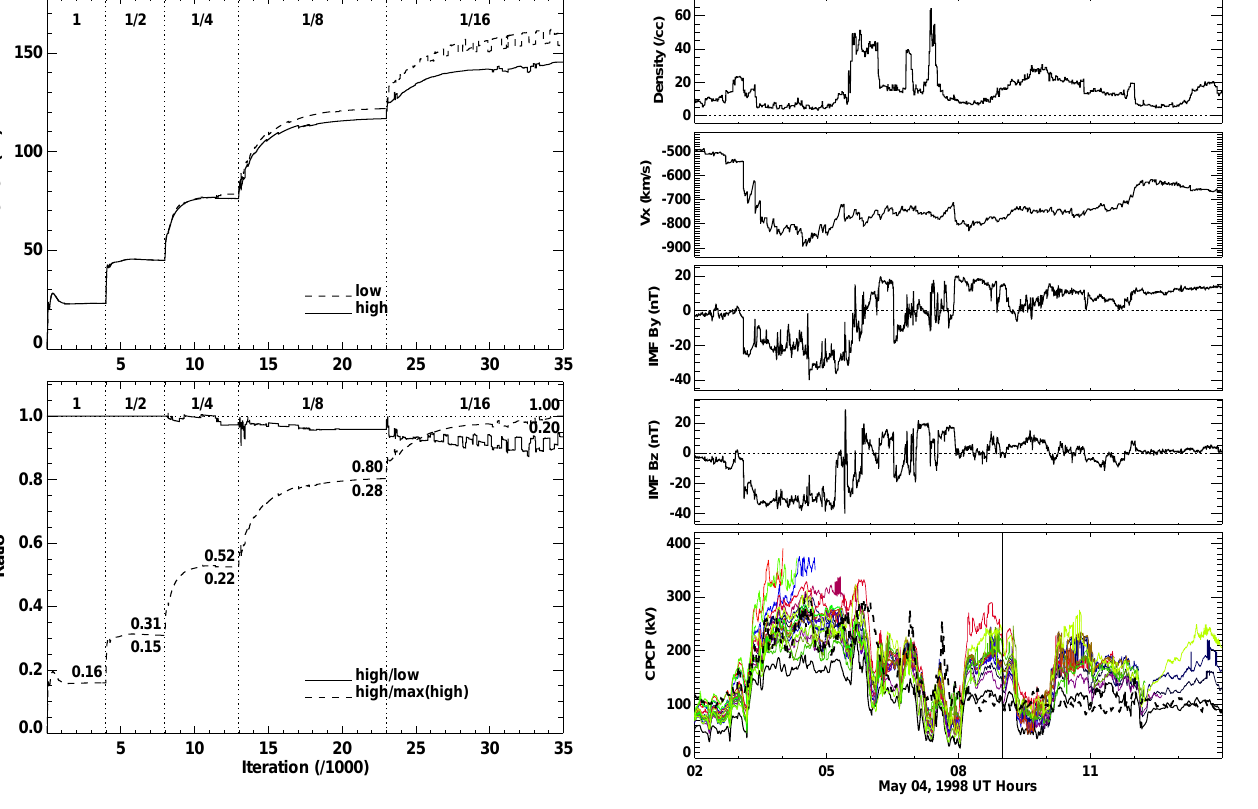
Fig. 12. From top to bottom: The solar wind density and tempera- ture, the IMF B y and B z and the ionospheric cross polar cap poten- tial from AMIE and the different simulations described in Fig. 1 on 4 May